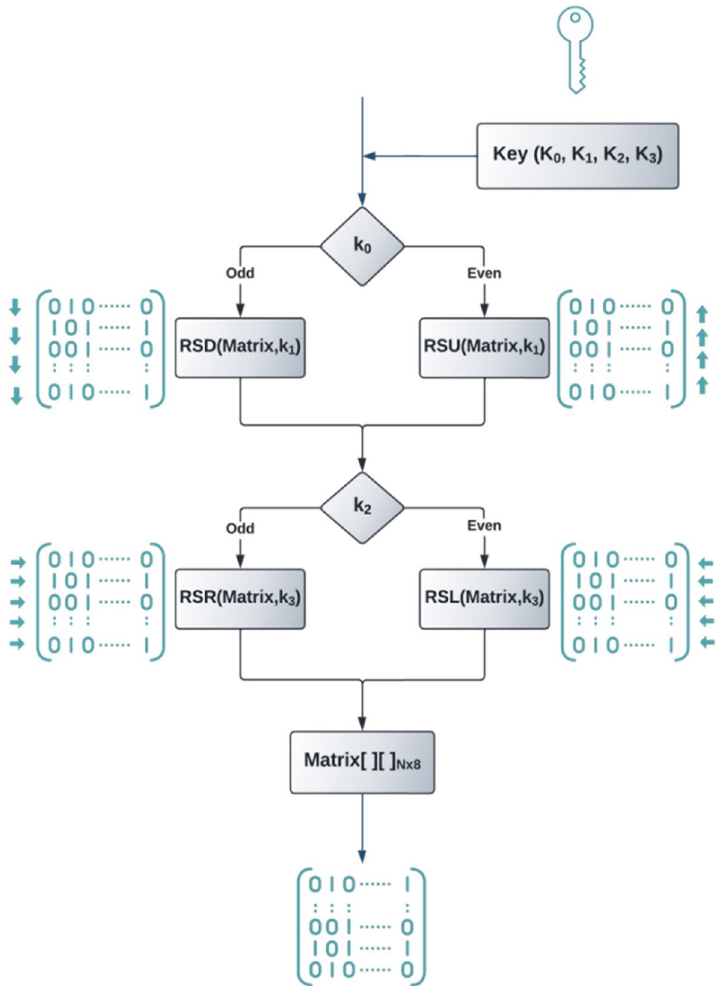
Fig. 2 Internal process of the proposed